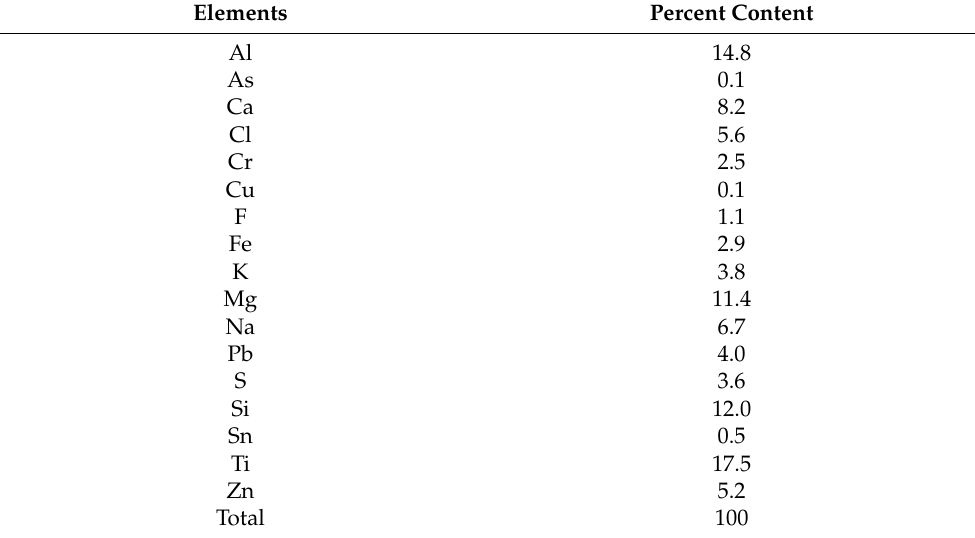
Table 5. The averaged elemental composition of the aerosol particles sampled in the workspace air of the aluminum titanium master alloy shop (in % to the sum of elements minus carbon and oxygen contained in the